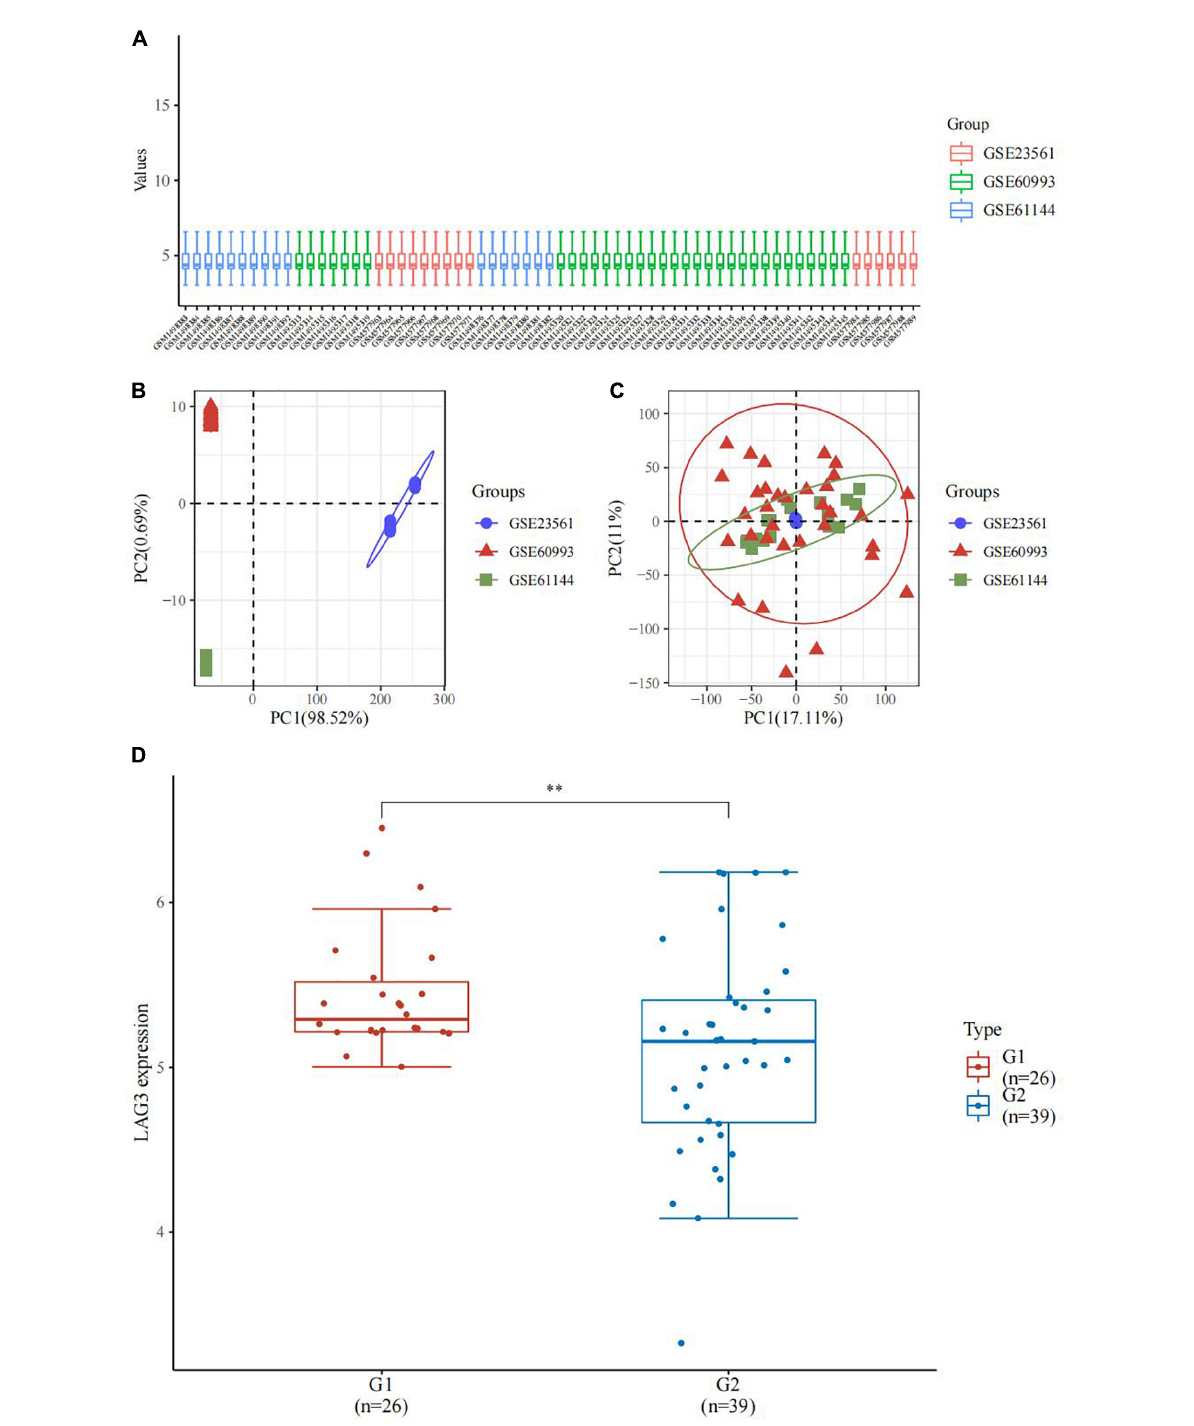
FIGURE4 LAG3 gene in coronary artery disease (CAD). (A) The box plot of the normalized data. Different colors represent different datasets. Rows represent samples, and columns represent the gene expression values in the samples. (B) Principal component analysis (PCA) results before batch removal for three data sets. Different colors represent different data sets. As shown in the schematic diagram, the three data sets are separated without any intersection. (C) PCA results after batch removal. The schematic diagram shows the intersection of three data sets which can be used as a batch of data for subsequent analysis. (D) The expression distribution of the LAG3 gene in peripheral blood. The horizontal axis represents different groups of samples: G1, normal control; G2, CAD group. ∗∗ P <